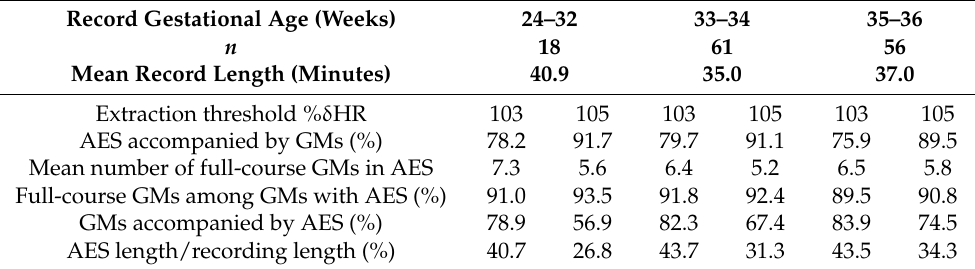
Table 2. Automatic extraction of GMs using the heart rate in the prone